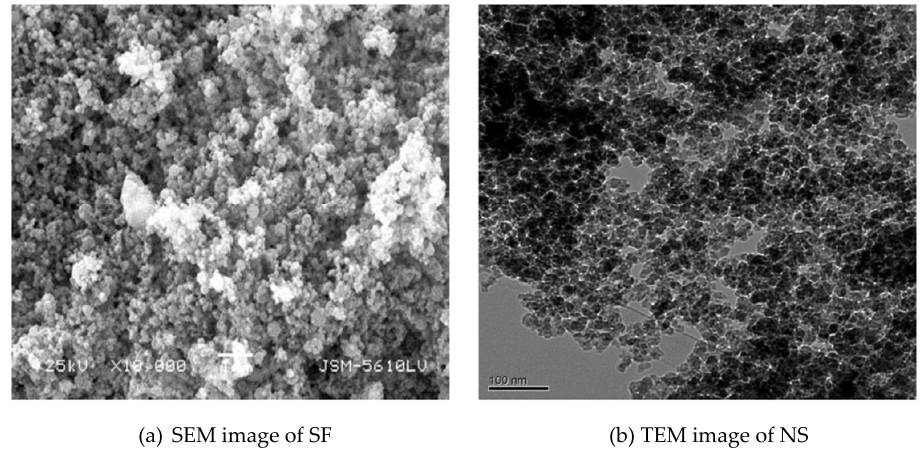
Figure 8. The microstructure of silica fume (SF) and nanosilica (NS). Reproduced from Zhang et al. [3] with permission from Elsevier.